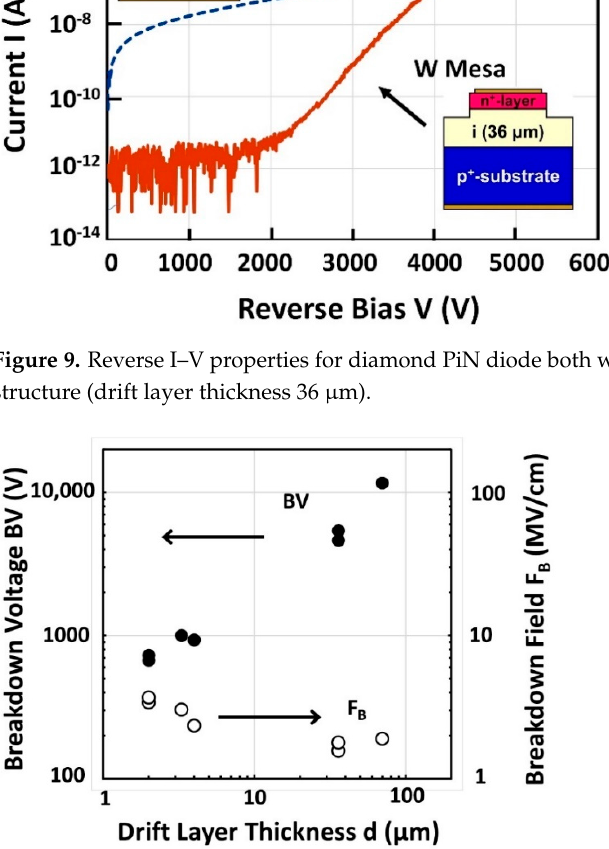
Figure 10. Break down voltage and breakdown field of diamond PiN diodes as a function of the drift layer thickness.